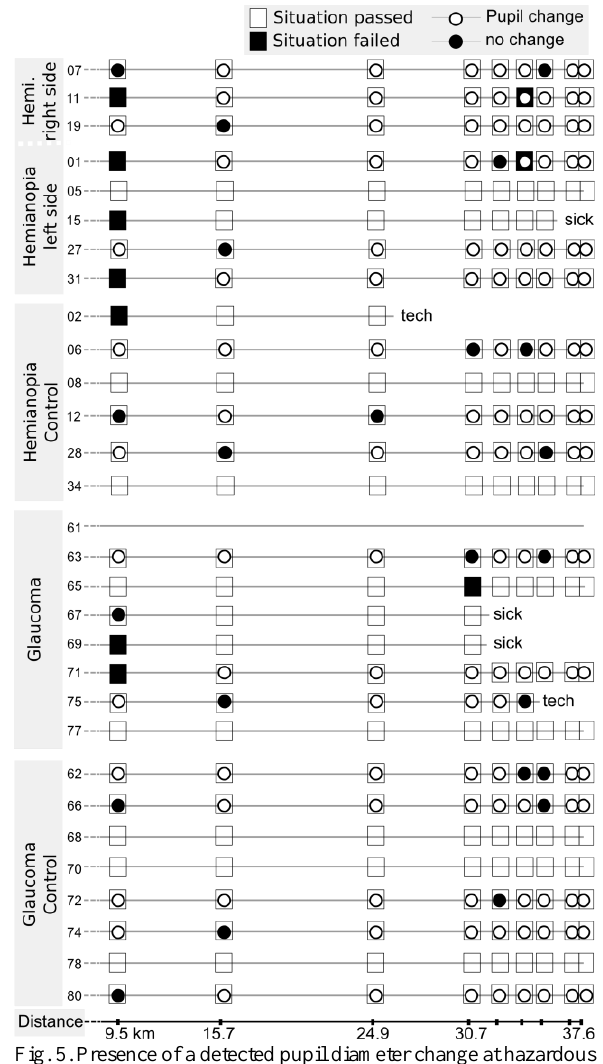
Fig. 5. Presence of a detected pupil diameter change at hazardous situations for all subjects and situations. Each row corresponds to the drive of one subject. The squares along the drive correspond to the hazardous situations and are filled black, if the driving in- structor judged an inadequate driving response. The inscribed cir- cle shows whether a pupil response was observed (filled white) or not (filled black). Lines without pupil markers correspond to trials excluded from data analysis due to a bad tracking rate of the eye-tracker. In addition, we provide locations of dangerous situations along the route. In each case, where a subject aborted the experiment, the reason (either technical difficulties or motion sickness) is provided.